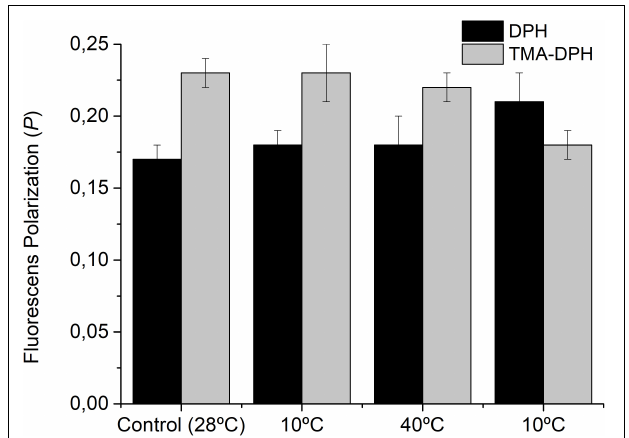
FIGURE 3 | Effect cyclic temperature changes on the fluorescence polarization of DPH and TMA-DPH in WC after 24 h of thermal change. S. meliloti (100 mL) culture was grown to a stationary phase at 28 ◦ C and then the thermal changes applied (10 ◦ C–40 ◦ C–10 ◦ C) for 24 h incubation periods. After exposure to each temperature, one aliquot (25 mL) was centrifuged and the biomass resuspended in 15 mmol L − 1 Tris–HCl buffer (pH 7.0) up to an OD600 nm = 0.2. The fluorescent membrane probe (DPH or TMA-DPH) 4 µ mol L − 1 was added to the resuspended culture (3 mL). Fluorescence polarization was measured at the same temperature from which the samples come. Values are the mean ± sd of three independent experiments.